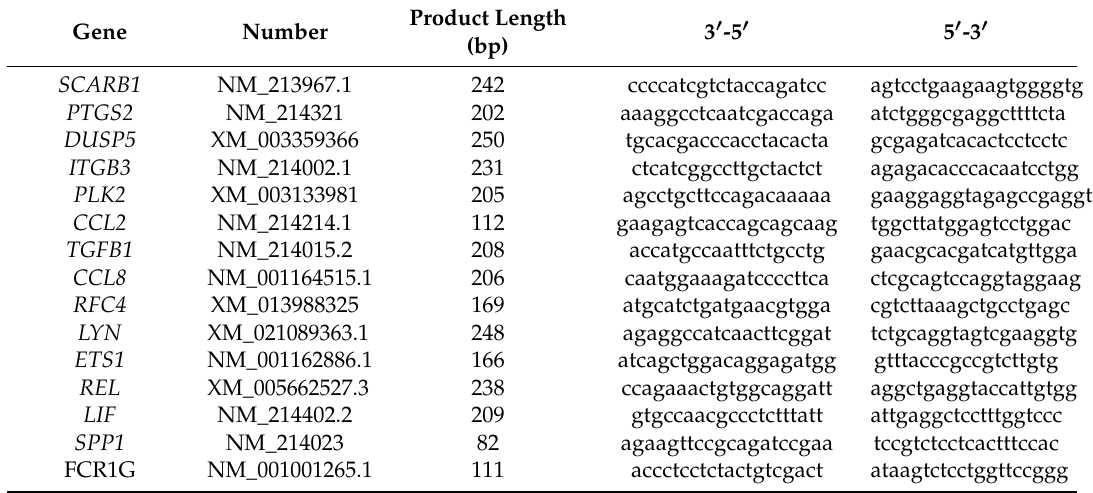
Table 3. Primer information and primer sequences used for the RT-qPCR